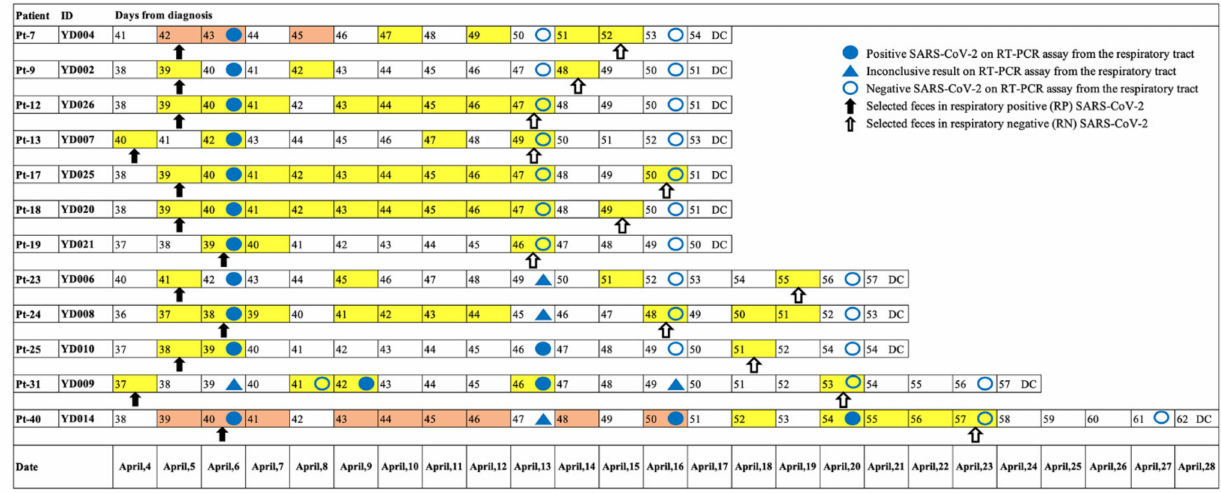
Figure 1. Timeline of the SARS-CoV-2 test results and selection of paired fecal samples of 12 patients. Numbers denote days after diagnosis. Total fecal collection dates are color-coded yellow and positive SARS-CoV-2 results are color-coded orange red. Filled blue circle, filled blue triangle, and empty circle represent a positive SARS-CoV-2 result of respiratory specimen, inconclusive result, and a negative result, respectively. Filled arrow and empty arrow denote paired fecal samples, feces in respiratory positive SARS-CoV-2, and feces in respiratory negative SARS-CoV-2, respectively. DC,